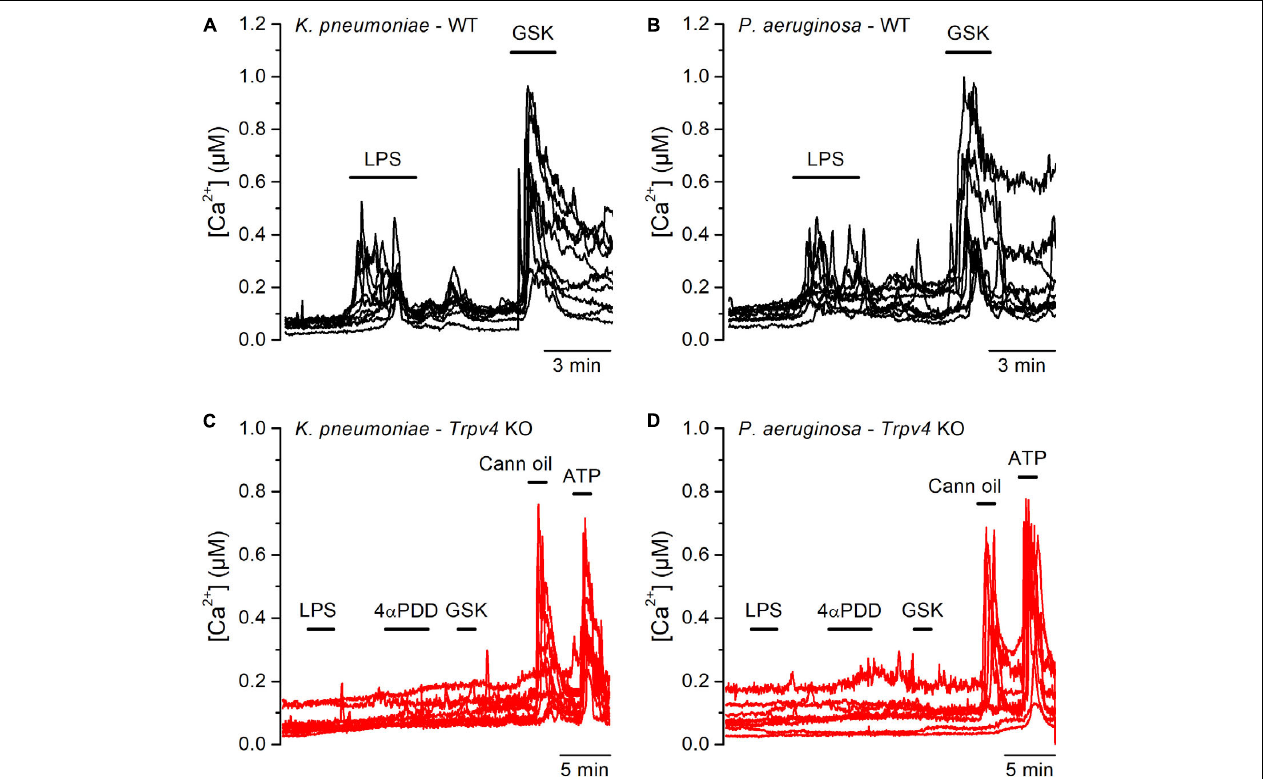
FIGURE 3 | Acute TRPV4-dependent stimulation of mouse urothelial cells by K. pneumoniae and P. aeruginosa LPS. (A–D) Representative intracellular Ca 2 + signals recorded in urothelial cells isolated from WT (panels A and B ) or Trpv4 KO (panels C and D ) mice. LPS extracted from K. pneumoniae (A,C) or P. aeruginosa (B,D) were applied at a concentration of 20 µ g/ml. The TRPV4 agonists 4 α PDD (2 µ M) and GSK1016790A (GSK, 10 nM) were used to evaluate the functional expression of TRPV4. A TRPV2 agonist (cannabis oil, 100 µ M) and ATP (10 µ M) were used to assess responsiveness of Trpv4 KO-derived cells.